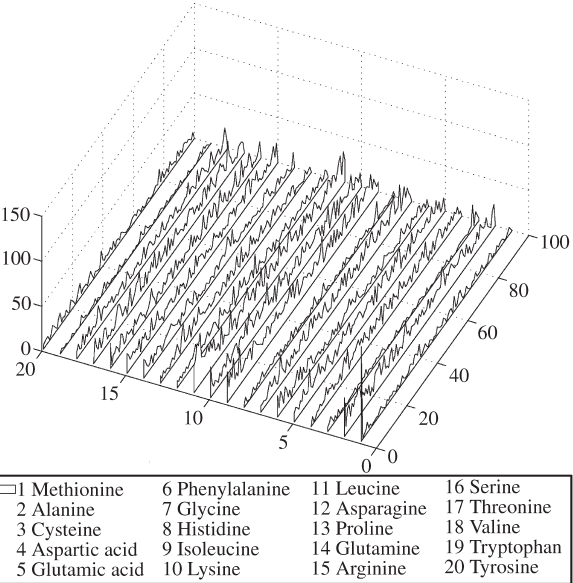
Figure 2 - Number of amino acids in the analyzed antigens.